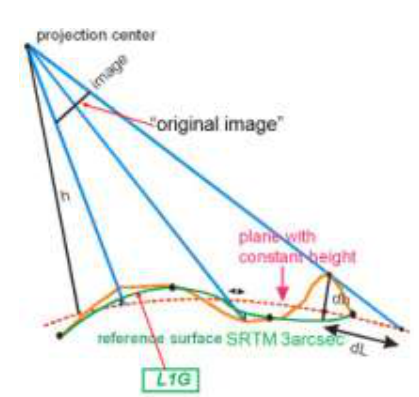
Figure 3. Satellite image